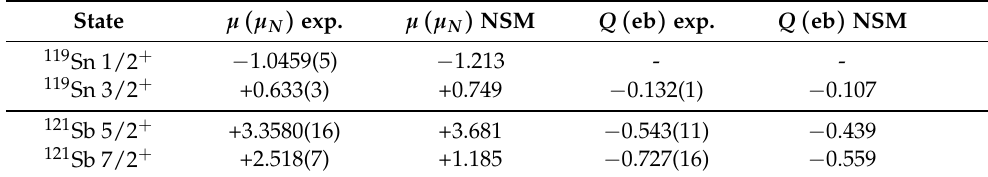
ef f = g free p = 1.5e, e n = 0.5e, g l l